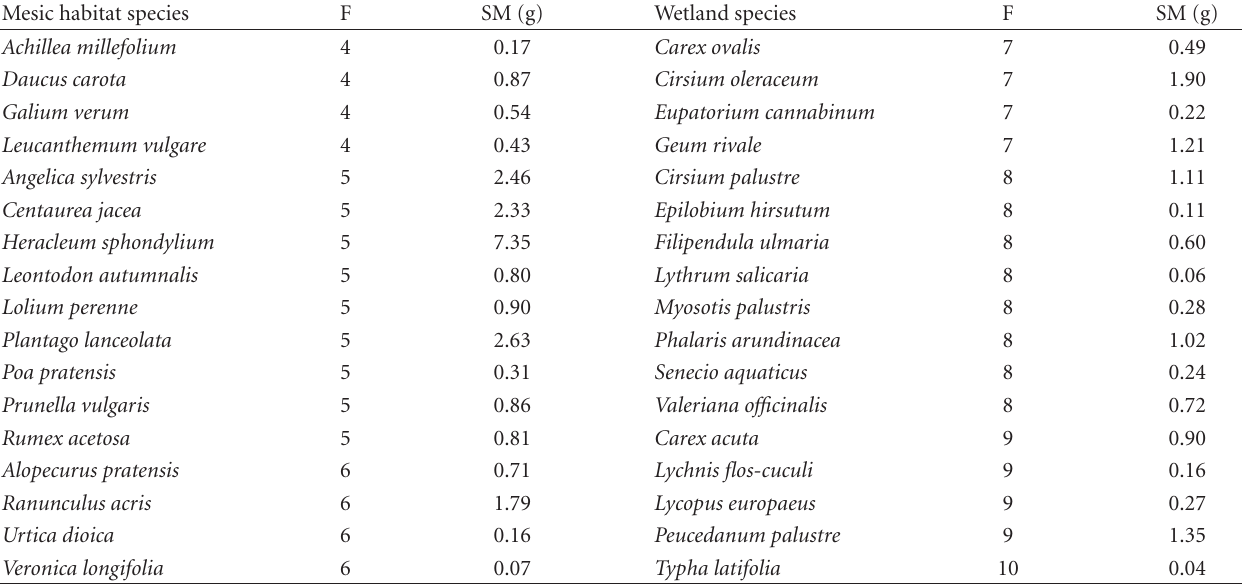
Table 5: Species selected for the experiments. F : Ellenberg moisture indicator [24]. SM: mass of 1000 seeds (amount introduced to each mesocosm); names follow Tutin et al.